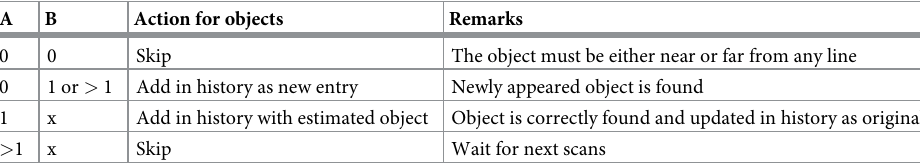
Table 1. Object tracking using local linear regression.